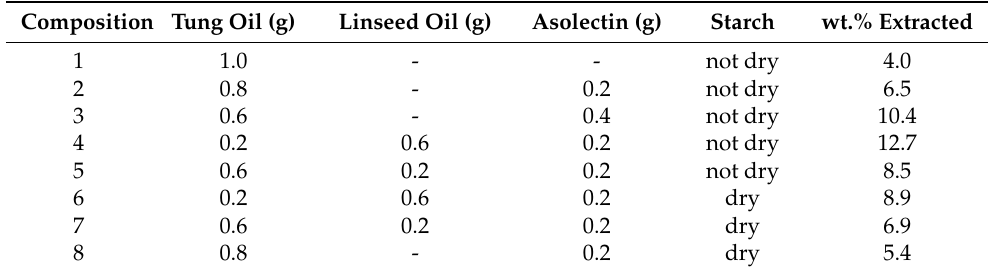
Table 1. Composite formulations investigated and corresponding Soxhlet extraction results. All composites were cured at 120 ◦ C for 170 min, followed by 140 ◦ C for 230 min.